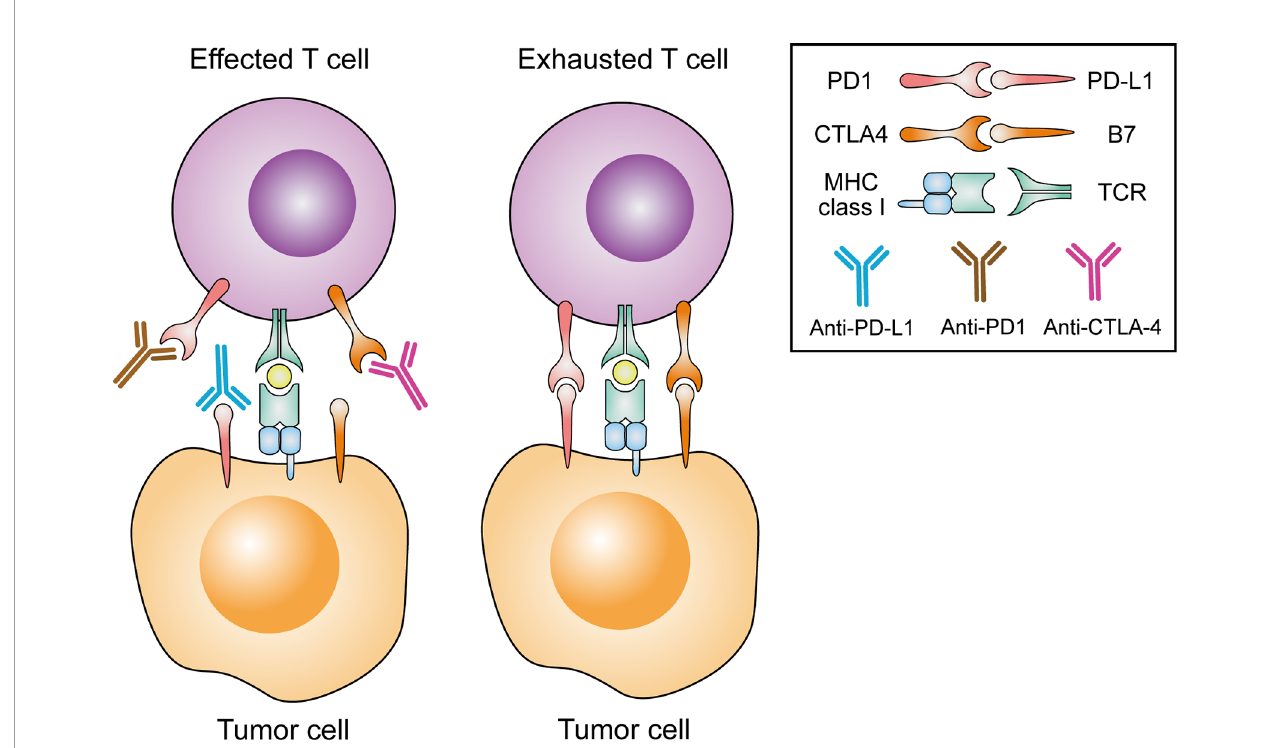
FIGURE 2 | Rationale for the current FDA-approved CRC immune checkpoint inhibitor strategies. TCR, T cell receptor; MHC, major histocompatibility complex; CTLA4, cytotoxic T lymphocyte antigen 4; PD1, programmed cell death 1; PD-L1, programmed cell death 1 ligand